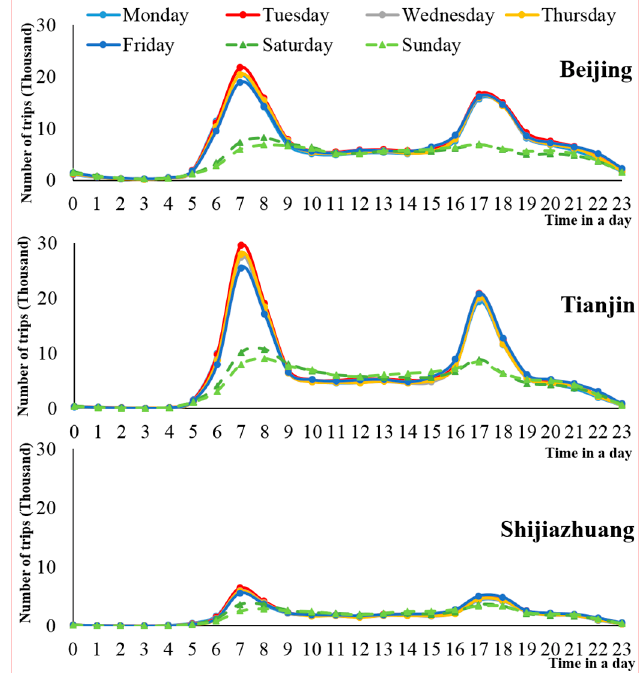
Figure 3. Order’s distribution by hours.